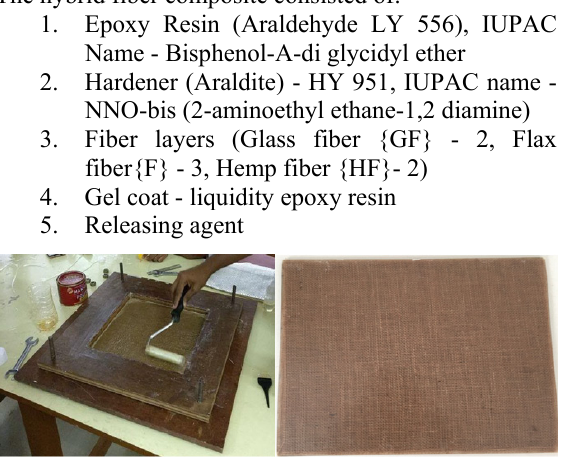
Figure 1. Hand lay-up process and the resulting composite sample